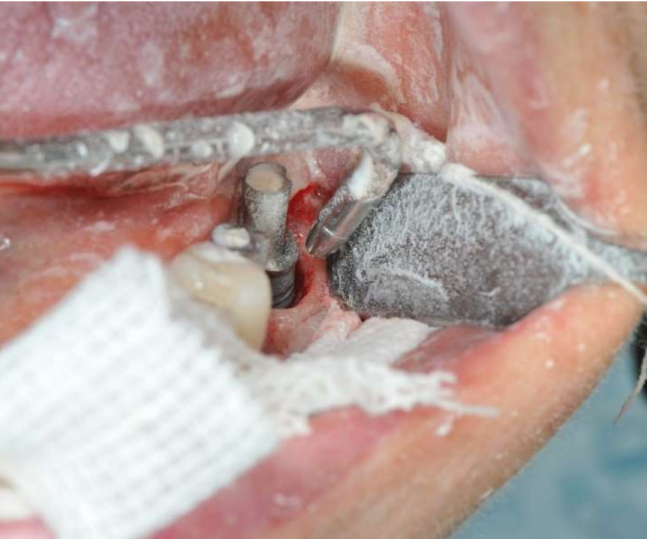
Figure 3. Intraoral image during open-flap air-powder abrasive debridement of the infected im- plant surface.